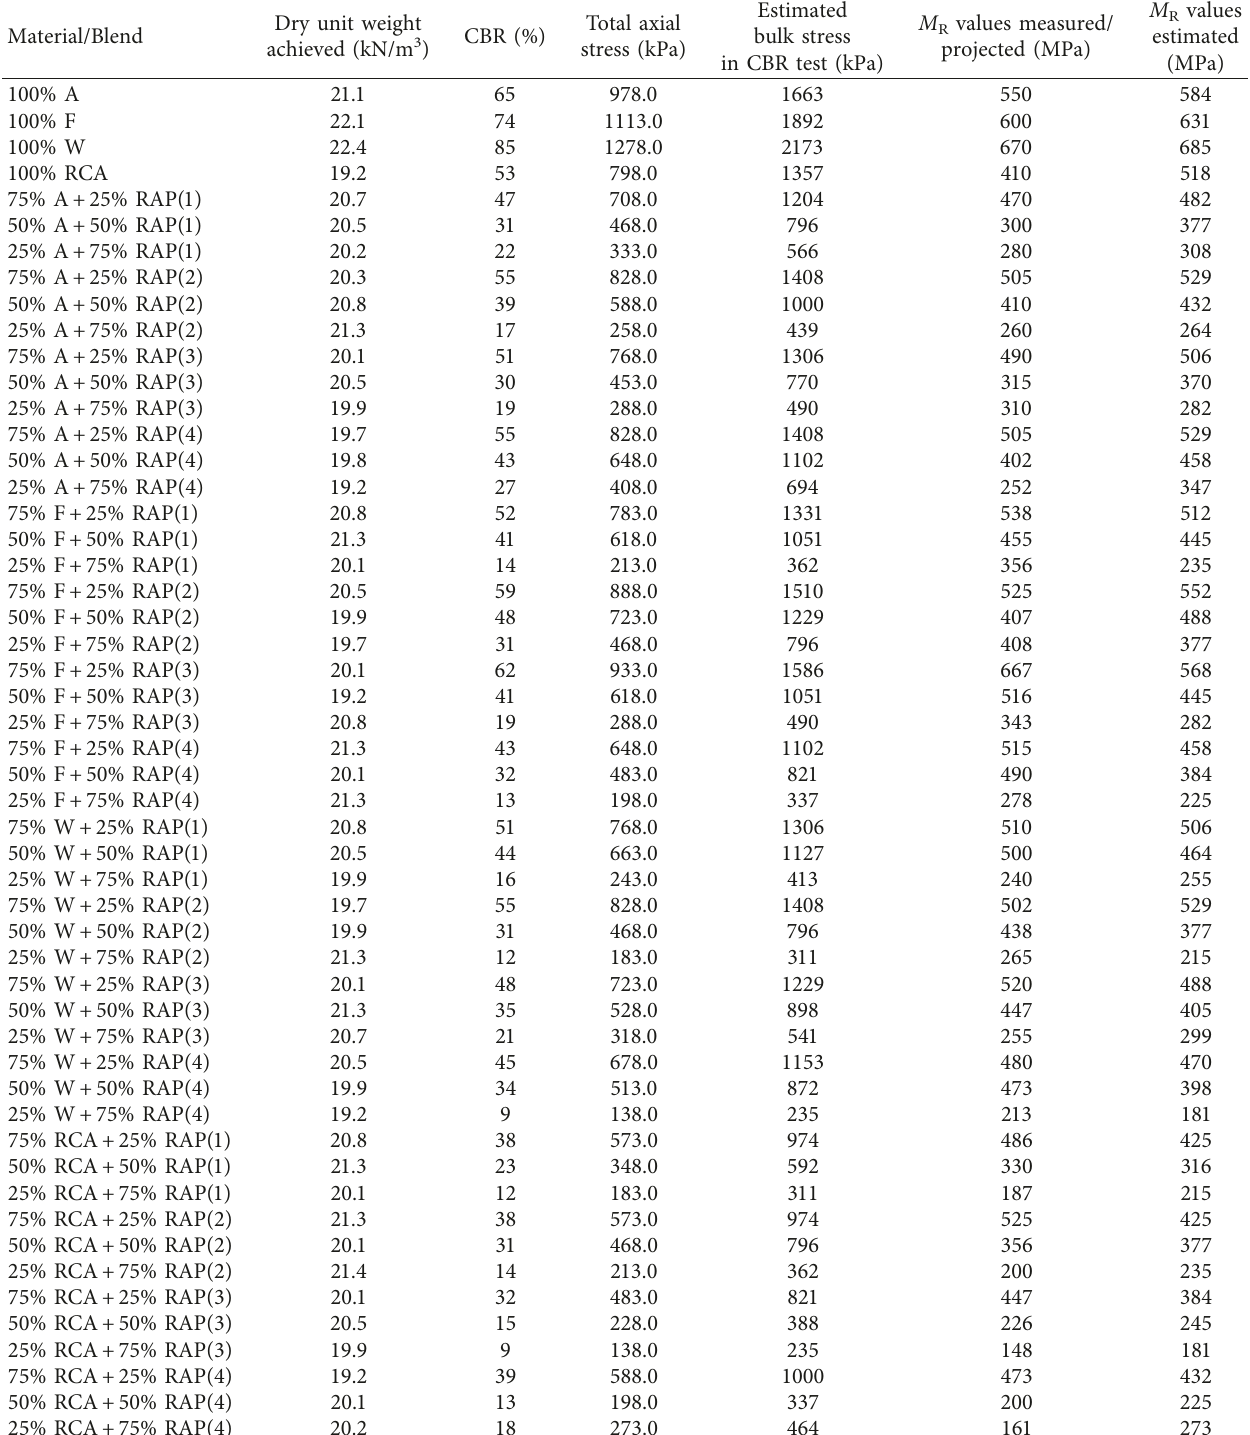
Table 5: A comparison of measured and estimated M